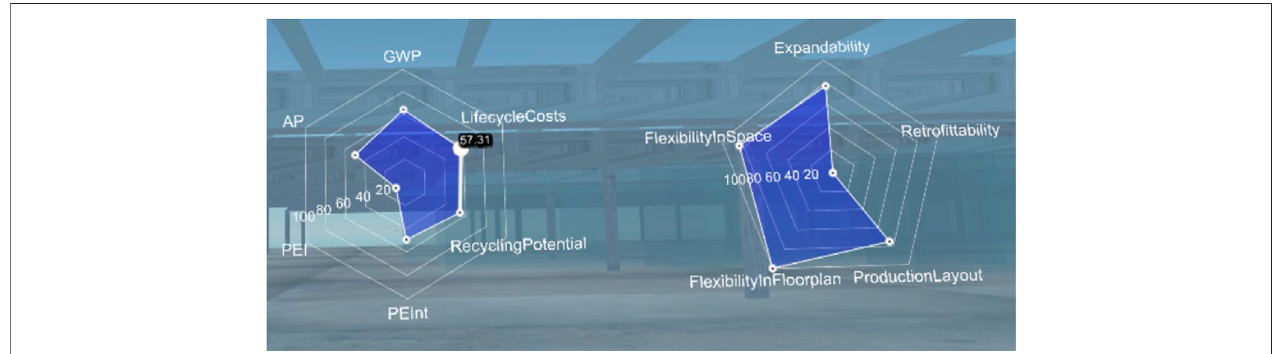
FIGURE 9 | Radar charts displaying the values of the objectives achieved with the current parameter selection (a screenshot of the immersed user ’ s view). The left chart shows the objectives describing the costs and environmental impact, the right one those describing the fl exibility of the building. Abbreviations: GWP, global warming potential; AP, acidi fi cation potential; PEI, primary energy use; PEInt, non-renewable primary energy use.